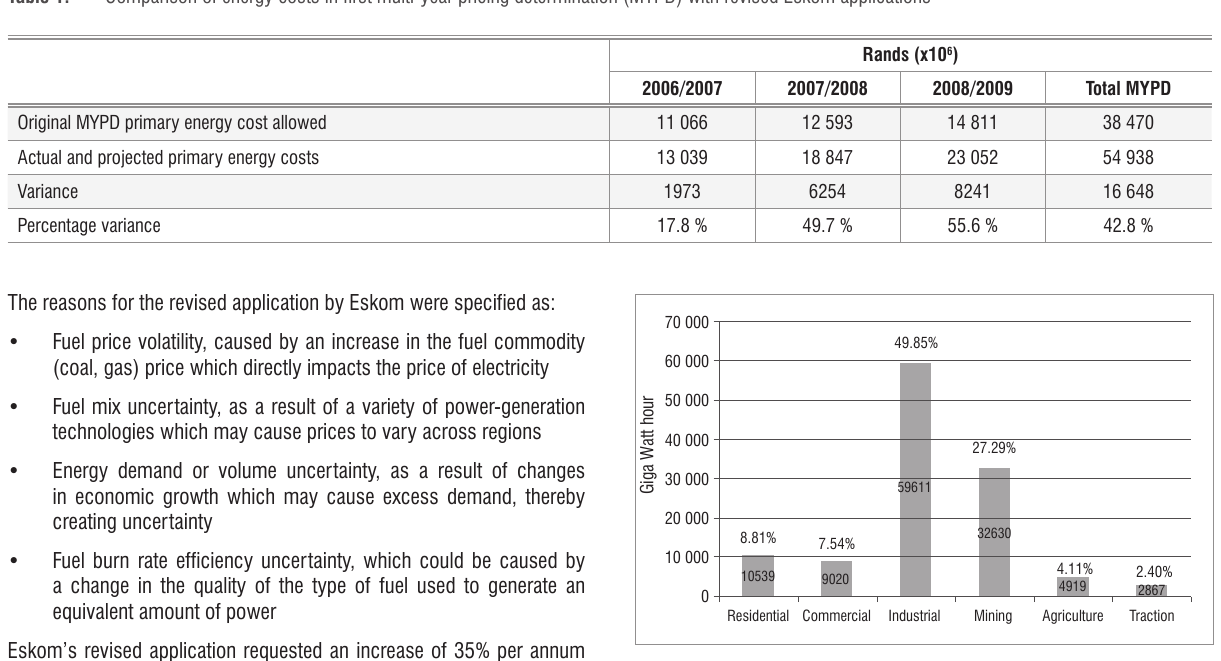
Comparison of energy costs in first multi-year pricing determination (MYPD) with revised Eskom